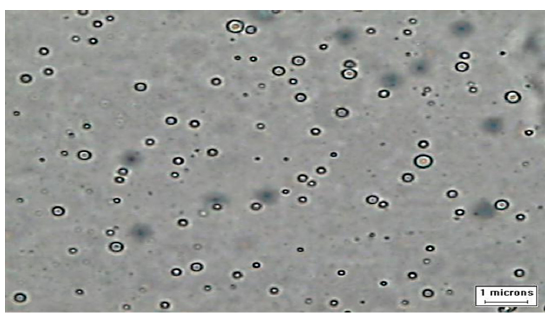
Figure 1. Photograph of physical structure of water droplets distributed within palm oil layer when 0.05 wt.% water was added.